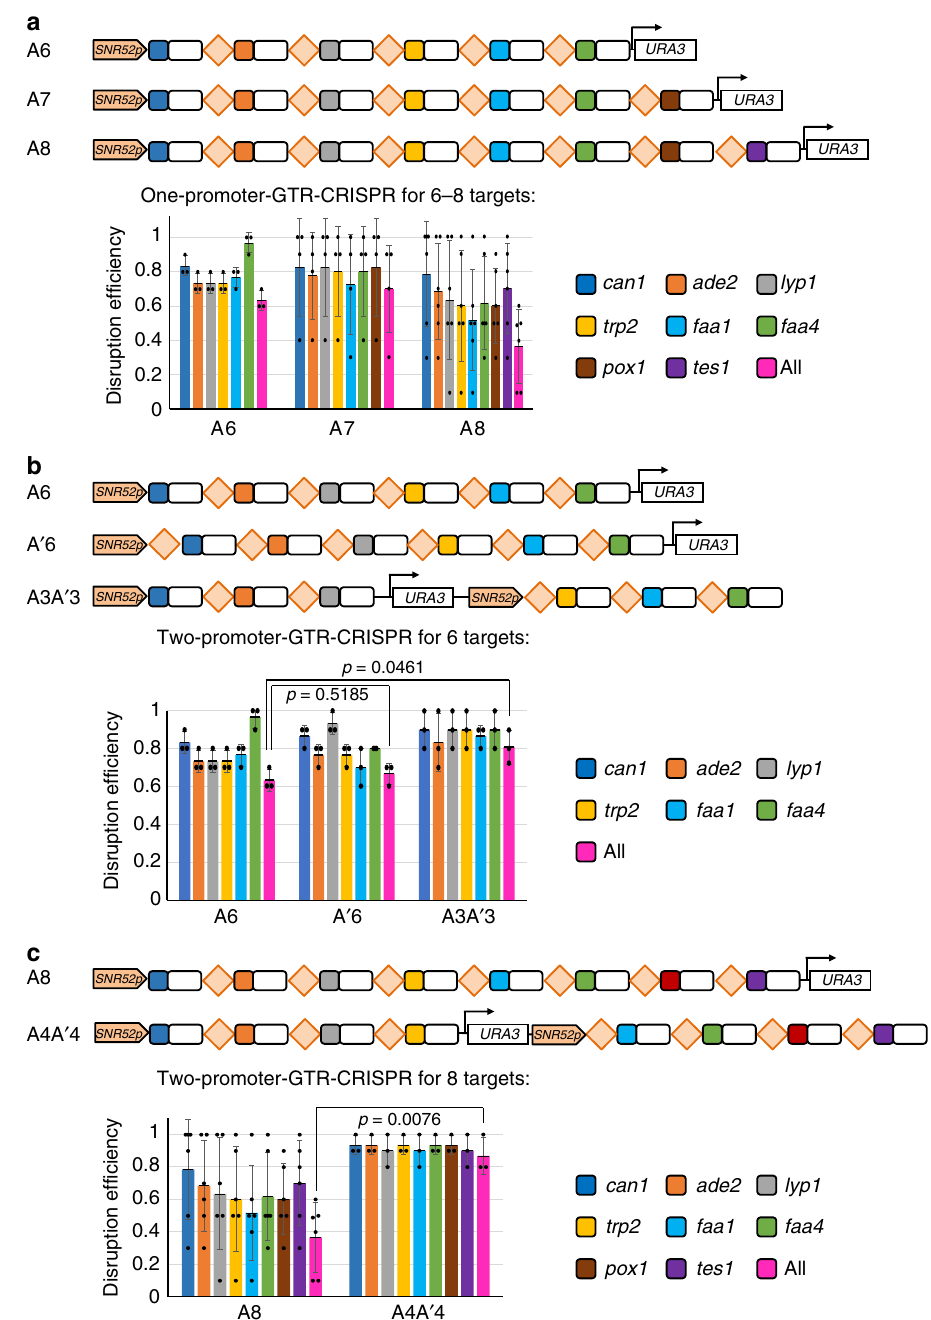
Fig. 3 Simultaneous disruptions for 6 – 8 genes using GTR-CRISPR. a Graphic representation and results of the one-promoter-GTR-CRISPR system for 6 – 8 genes. b Graphic representation and results of one-fusion-promoter- or two-promoter-GTR-CRISPR system for 6 genes. c Graphic representation and results of simultaneous 8-gene disruptions by the two-promoter-GTR-CRISPR system. The data of bar charts represent mean averages of each gene or overall disruption ef fi ciencies. Each black dot represents the gene disruption ef fi ciency of 10 colonies from each biological replicate, and the error bars indicate the standard deviations of all ( n ≥ 3) biological replicates. The statistical analyses are performed using unpaired t Test. Source data are provided as a Source Data fi